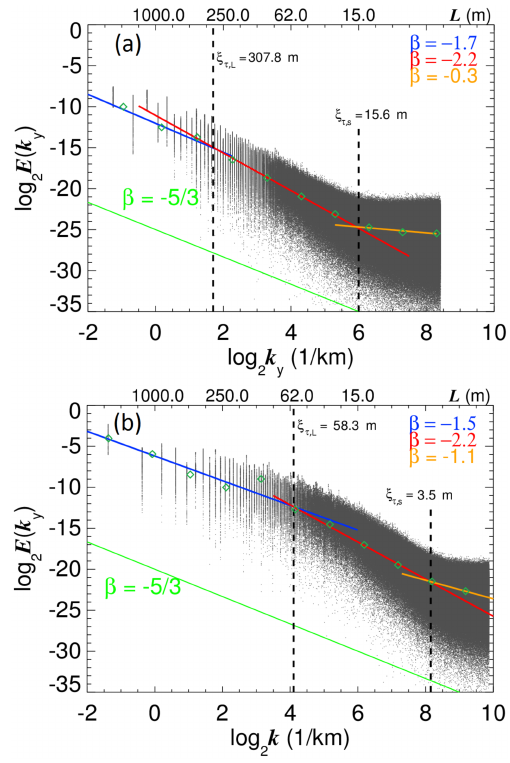
Figure 6. One-dimensional power spectral density E(k y ) (gray dots) for each spatial pixel on the swath axis of the τ field from (a) case Ci-01 and (b) case St-07. Scale-invariant slopes β are marked with solid coloured lines. The E(k rn ) derived from the oc- tave binning are included as dark green diamonds. Scale breaks ξ τ, L and ξ τ, s are indicated by dashed